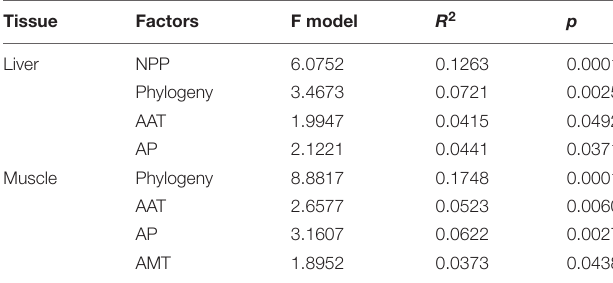
TABLE 1 | The permutation ANOVAs on liver and muscle metabolomes (Bray-Curtis distance, permutations = 9,999) for the best models.